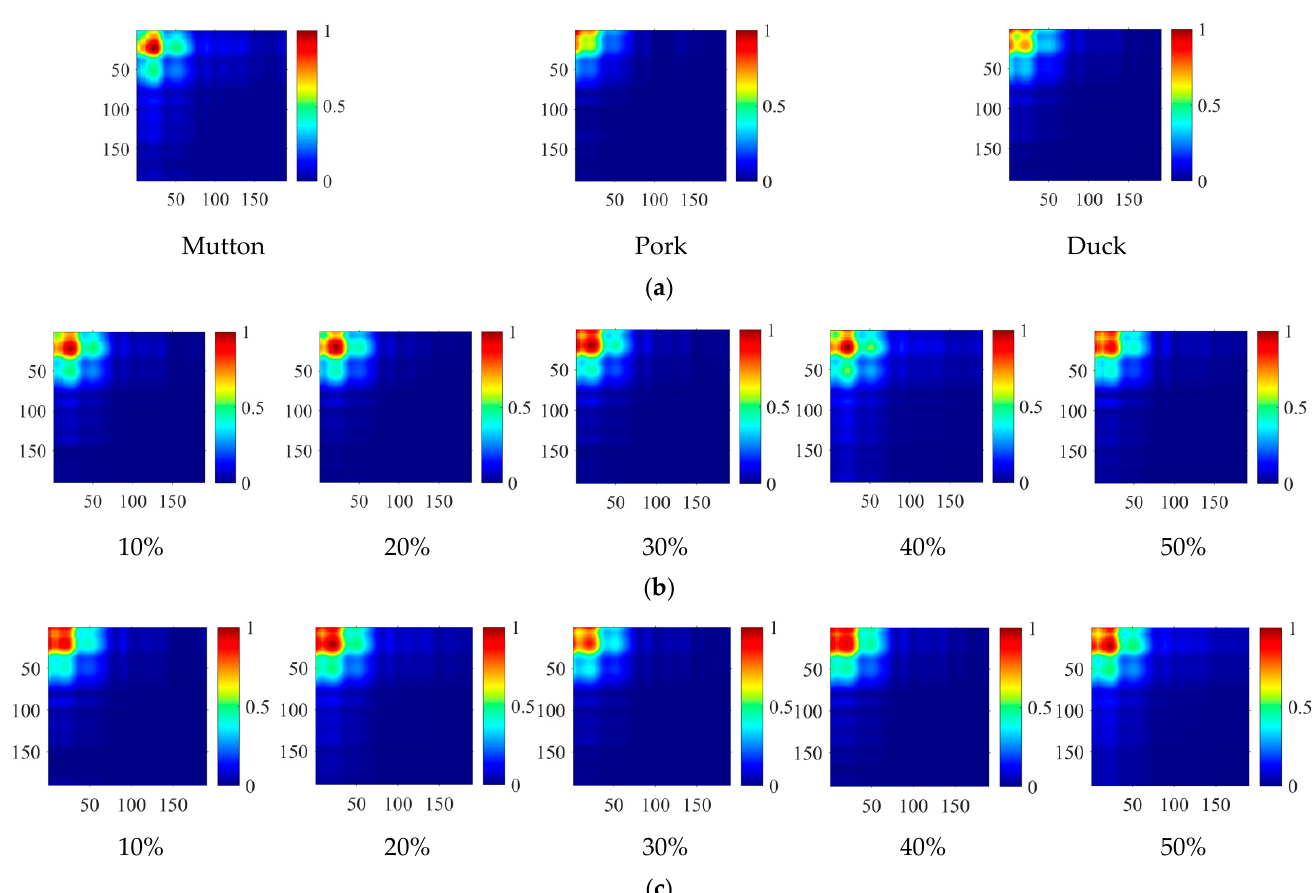
Figure 5. Two-dimensional (2D) spectral information matrixes of ( a ) pure meat; ( b ) adulterated mutton with pork in different proportions; ( c ) adulterated mutton with duck in different proportions.